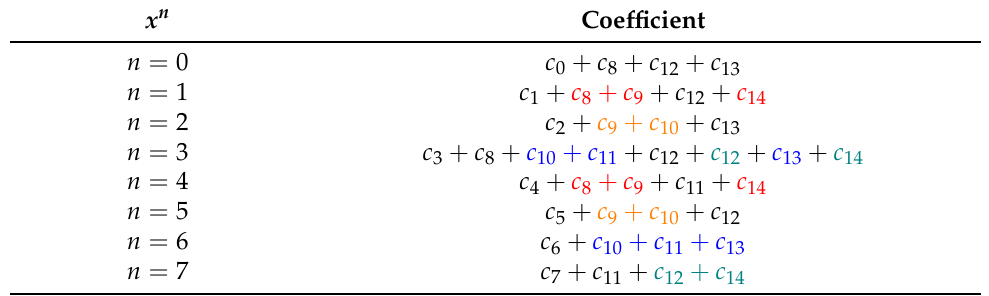
Table 4. Results of modular reduction of F 2 8 / ( x 8 + x 4 + x 3 + x + 1 ) .